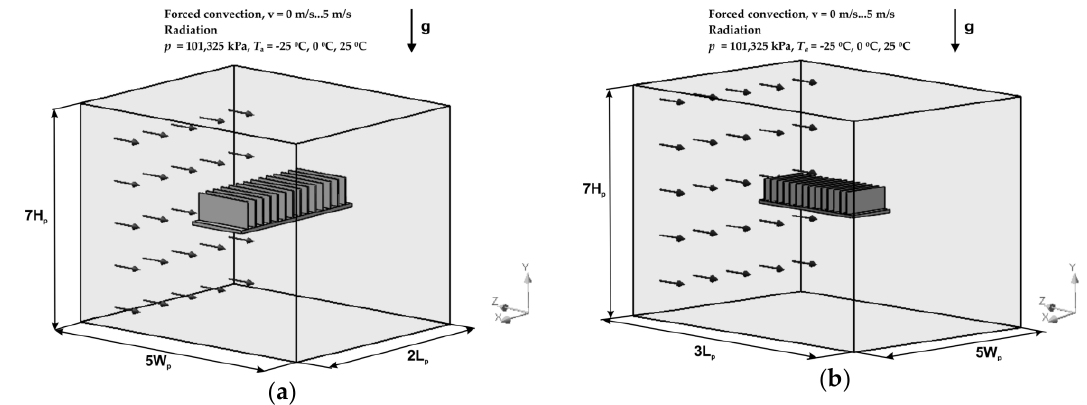
Figure 18. Calculation domain of LED panel for forced airflow: ( a ) on the radiator’s side and ( b ) directly on the radiator.